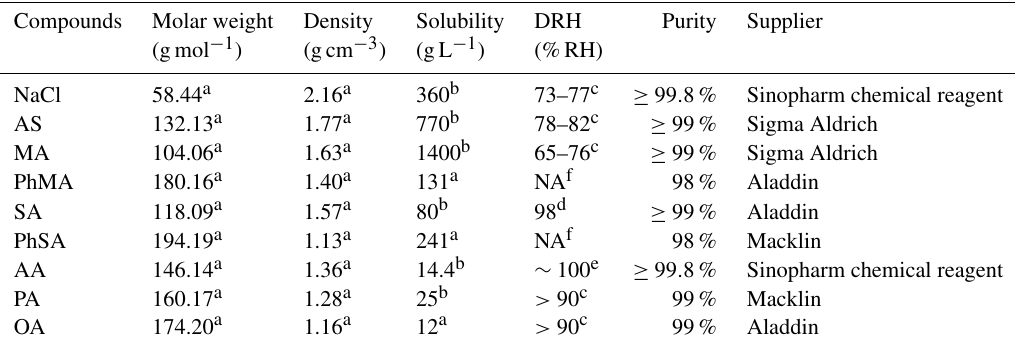
Table 1. Substances and their relevant properties investigated in this study.